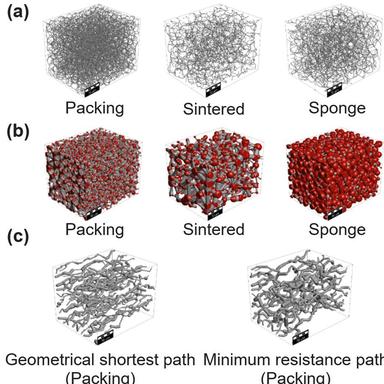
Feature extraction from porous media based on the connectivity of pores. (a) Medial axis of pore phase. (b) Pore-throat network (the red sphere and gray cylinder represent pore and throat, respectively; the throats are visualized as cylinders with the diameters of throat spheres). (c) Geometrical shortest path and minimum resistance path (the ancestor pores are not shown for better recognition of the defined paths).